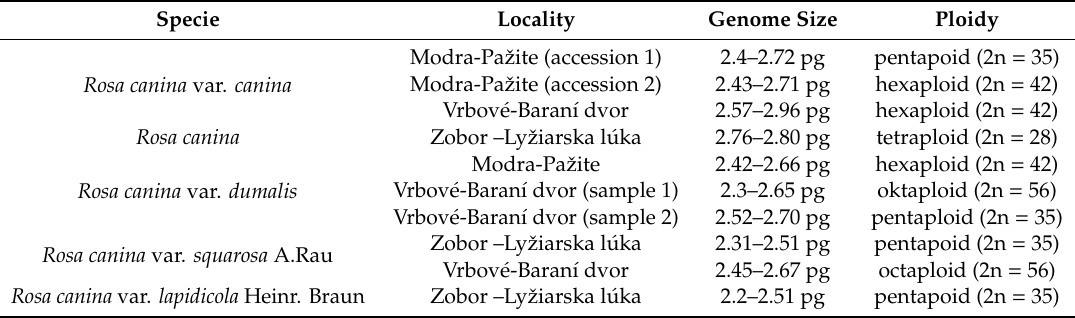
Table 4. Species of Rosa L. from analyses localities with the determined genome size and